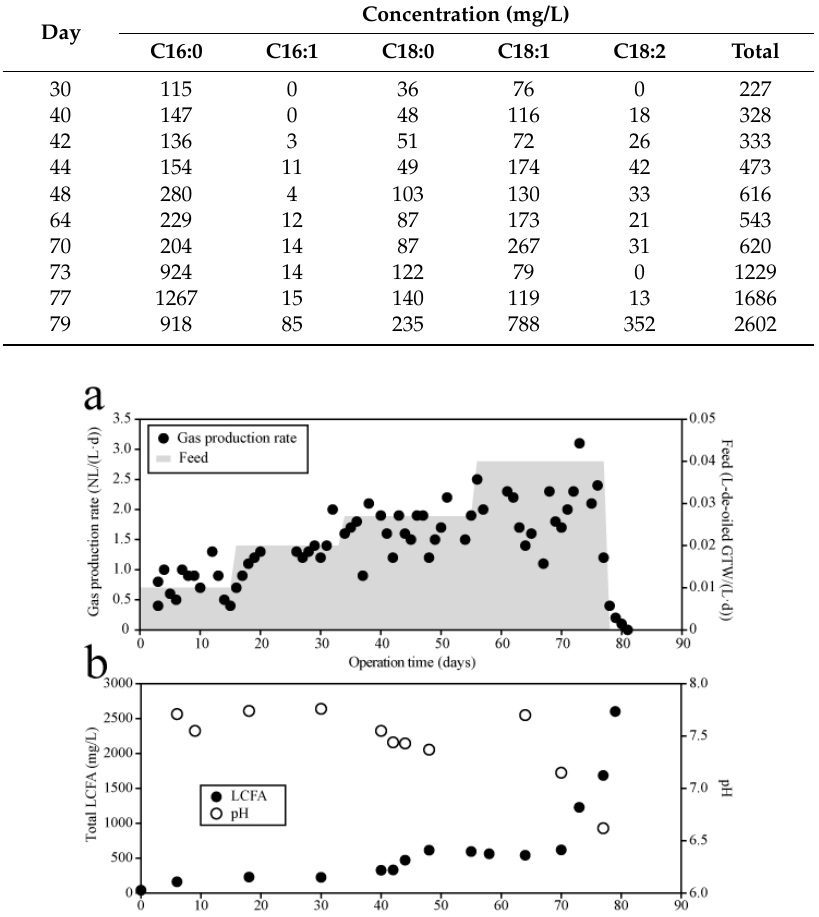
Table 1. The main composition of LCFAs in digestate samples ( n = 1).